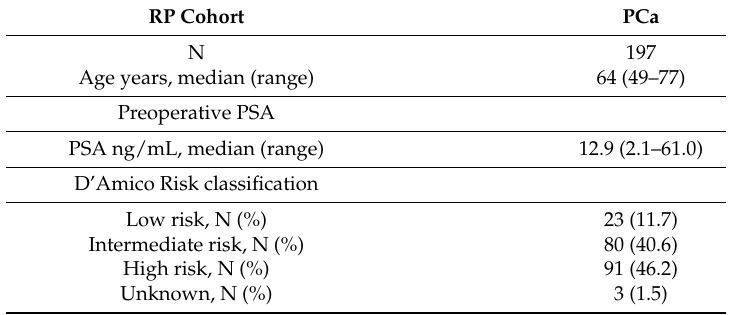
Table 1. Clinicopathological characteristics of radical prostatectomy (RP) patient cohort and